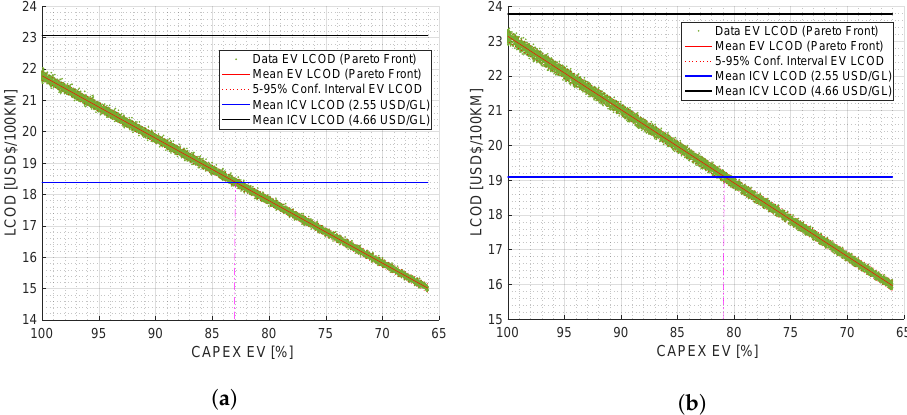
Figure 3. Sensibility Analysis with respect to EV CAPEX . ( a ) Case A ( r = 10%). ( b ) Case B ( r =